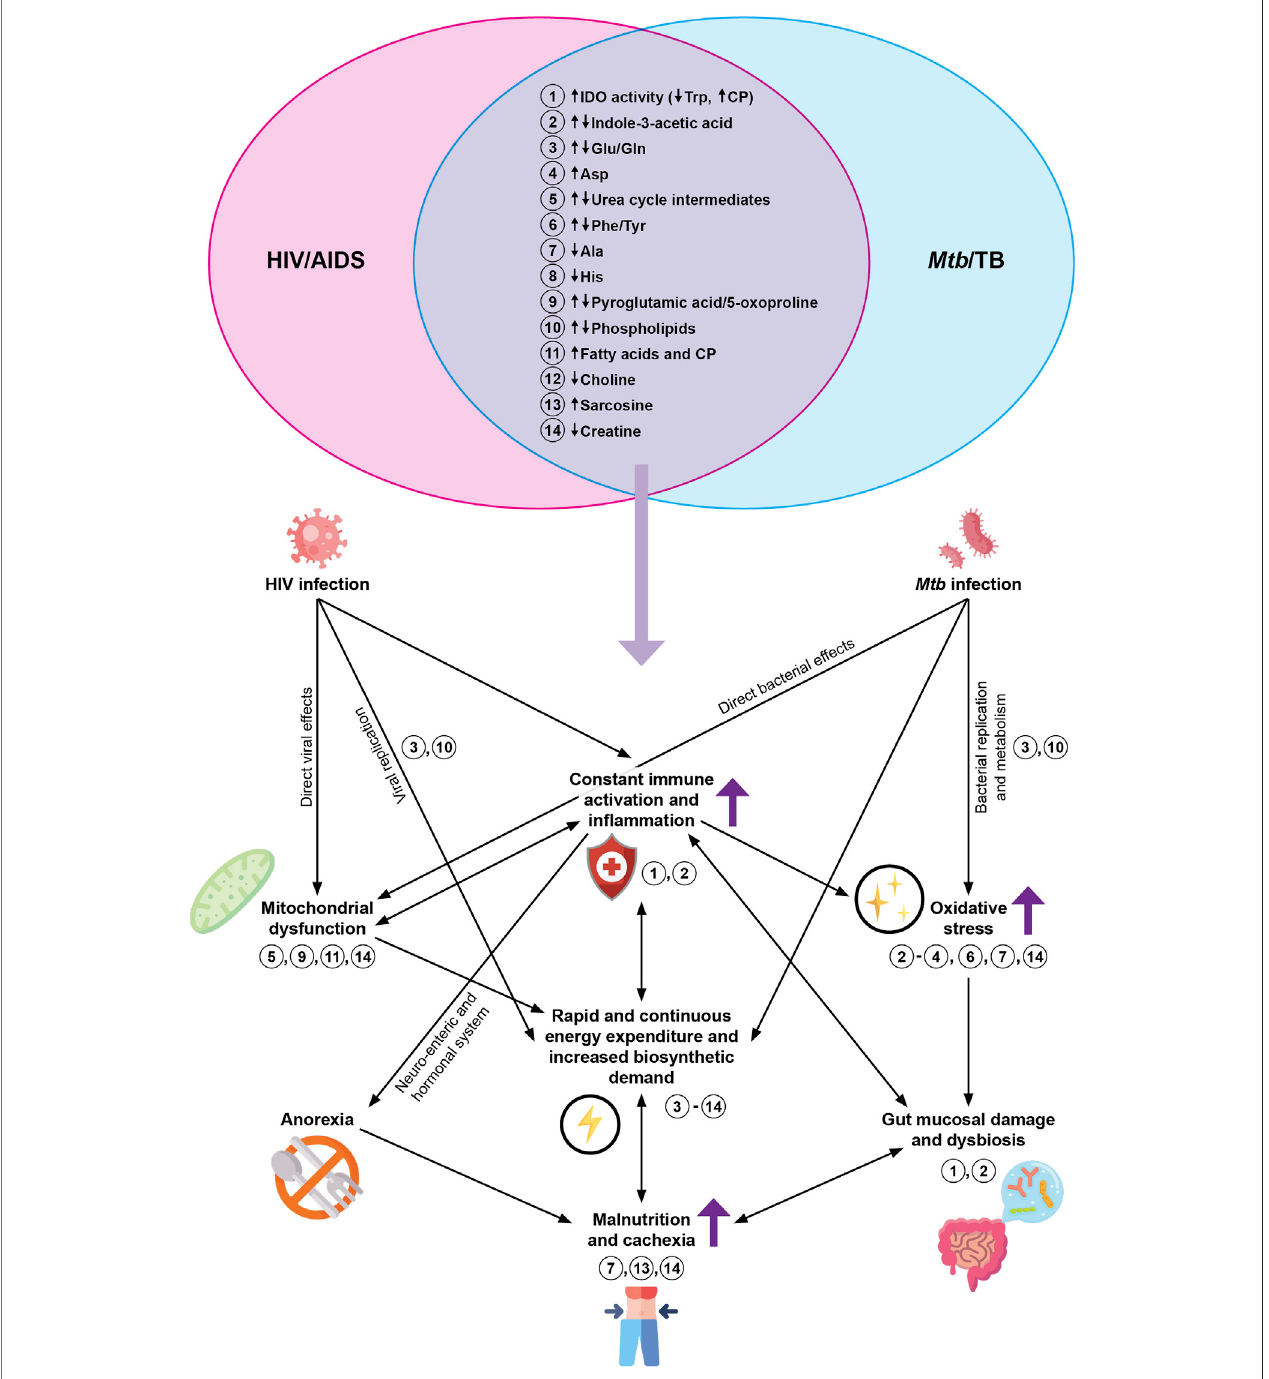
FIGURE 1 | The proposed metabolic effects of HIV/TB co-infection, based on the overlapping fi ndings of prior blood-based HIV infection and TB metabolomics studies (as indicated by the Venn diagram at the top). The dark purple arrows represent effects that are known to be exacerbated during HIV/TB co-infection. The light purple arrow represents metabolites hypothesized to be altered during HIV/TB co-infection, based on published literature. The numbers indicate the overlapping metabolites and where they play a role in what is known about host metabolism during HIV/TB co-infection. Abbreviations: HIV, human immunode fi ciency virus; AIDS, acquired immunode fi ciency syndrome; Mtb , Mycobacterium tuberculosis ; TB, tuberculosis; IDO, indoleamine-2,3-dioxygenase; Trp, tryptophan; CP, catabolic products; Glu, glutamate; Gln, glutamine; Phe, phenylalanine; Tyr, tyrosine; Asp, aspartate; Ala, alanine; His, histidine.